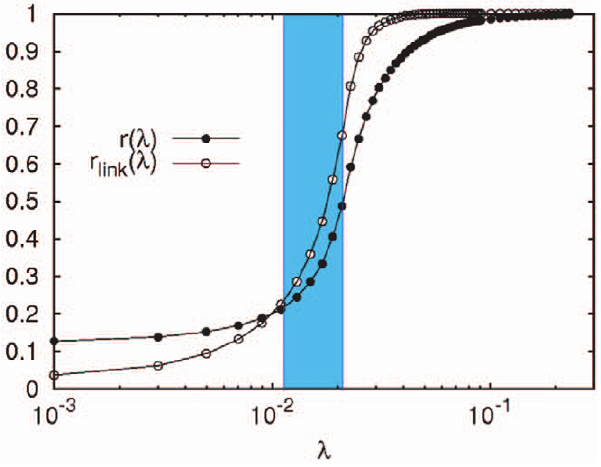
Figure 2. Synchronization diagrams. The figure shows the evolution of the Kuramoto order parameter r and the fraction of synchronized links r link as the coupling strenght is increased. The transition from asynchronous dynamics to global dynamical coherence as l grows is clear from the two curves. The region in blue corresponds to the onset of synchronization.